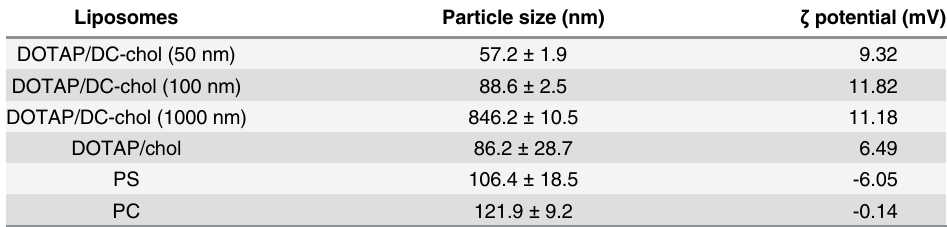
Table 1. Physicochemical Properties of the Liposomes used in this Study.